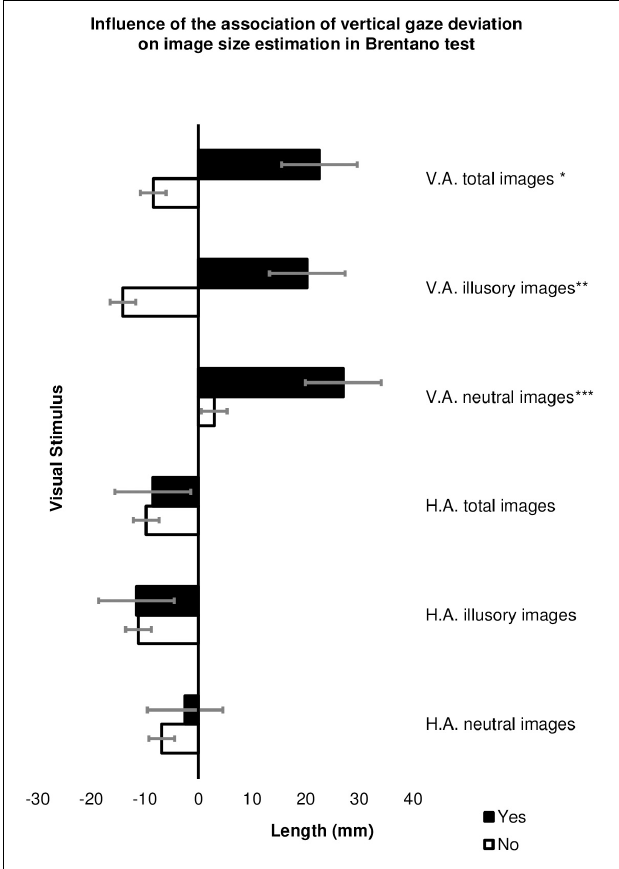
FIGURE 7 | Influence of the presence of vertical strabismus associated with horizontal strabismus to estimate image size (in millimeters) in the Brentano test in the Cases Group among patients with strabismus and associated vertical deviation ( n = 19) and patients with strabismus without associated vertical deviation ( n = 29). HA, horizontal adjustment; VA, vertical adjustment; * p -value = 0.017, ** p -value = 0.015, *** p -value = 0.016 The error bars shown represent the Standard